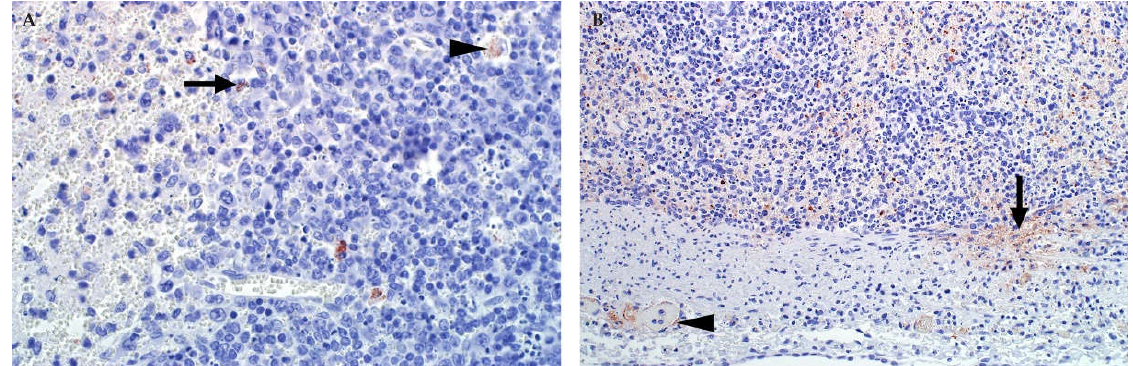
Figure 10. Spleen of a RVFV-infected sheep (NovaRed IHC as detailed in Figure 5). ( A ) In this specimen from an adult sheep, viral antigen is present in multiple macrophages in the marginal zone of the white pulp (arrow). Labelling is also present in a tingible-body macrophage in the white pulp (arrowhead), mag 400×. ( B ) Prominent immunolabelling of non-cell-associated antigen and cellular debris in the subcapsular red pulp (arrow). Viral antigen is also present in endothelial cells (arrowhead) and the capsular smooth myocytes, mag 200×.